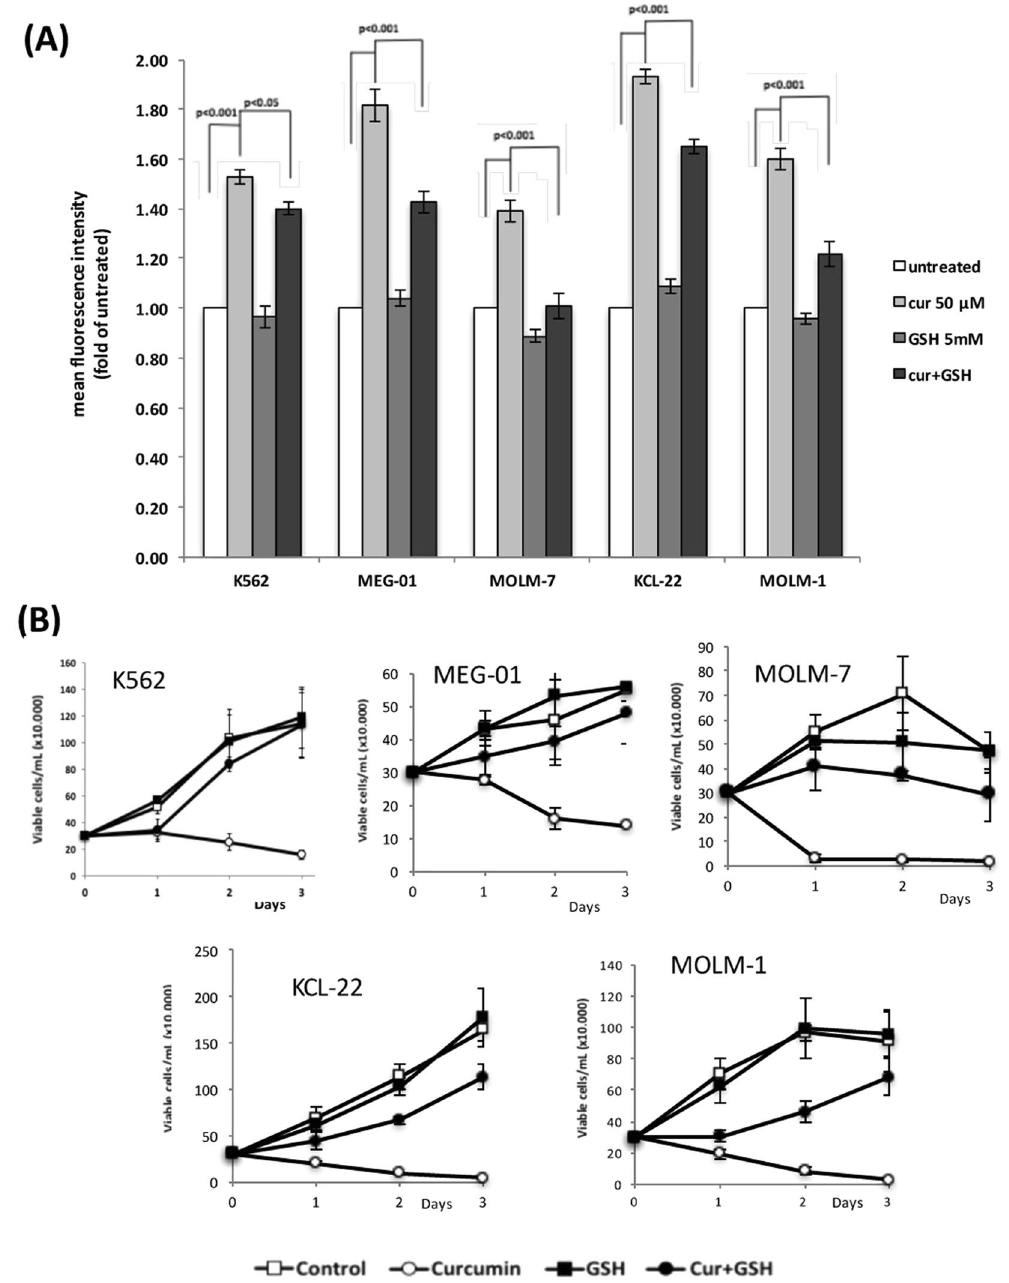
Figure 5. Curcumin increases intracellular ROS levels to inhibit leukemic cell proliferation. ( A ) Cells (5 × 10 5 cells/mL) were treated with curcumin (50 μ M), GSH (5 mM), and both for 24 hours, and subjected to the ROS detection analysis using FACS. ( B ) Cells (3 × 10 5 cells/mL) were cultured in the presence of curcumin (50 μ M), GSH (5 mM), and both, and enumerated every day using the trypan blue staining method. Results are the average of three independent experiments (means ±